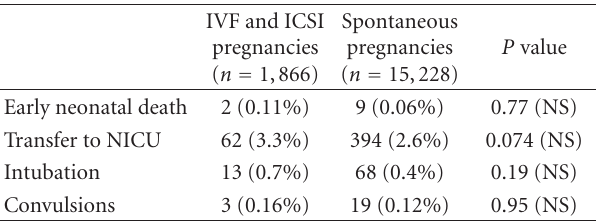
Table 3: Neonatal outcome.